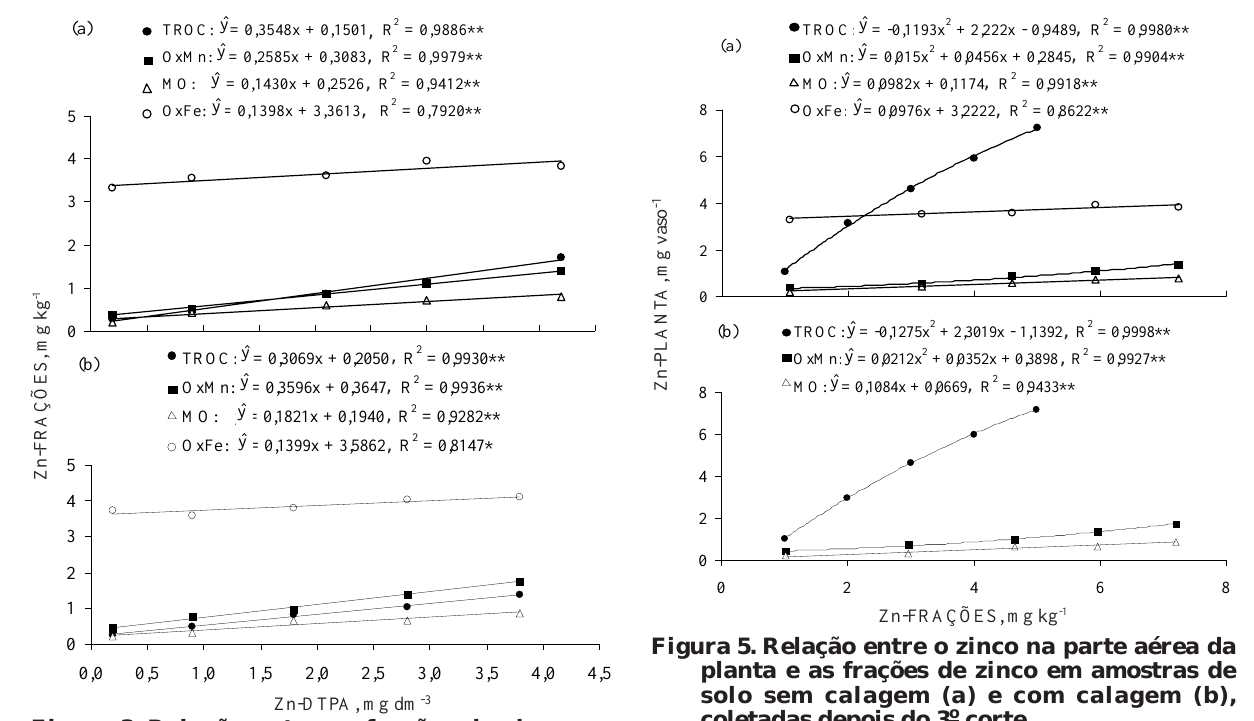
Figura 3. Relação entre as frações de zinco e o extraído por DTPA em amostras de solo sem calagem (a) e com calagem (b), coletadas depois do 3 o corte.